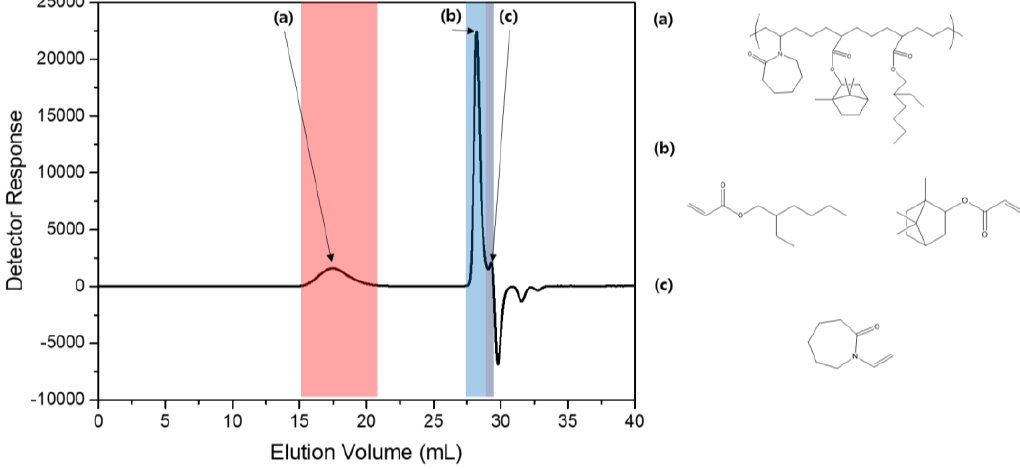
Table 1. Molecular weight distribution of the prepolymer.